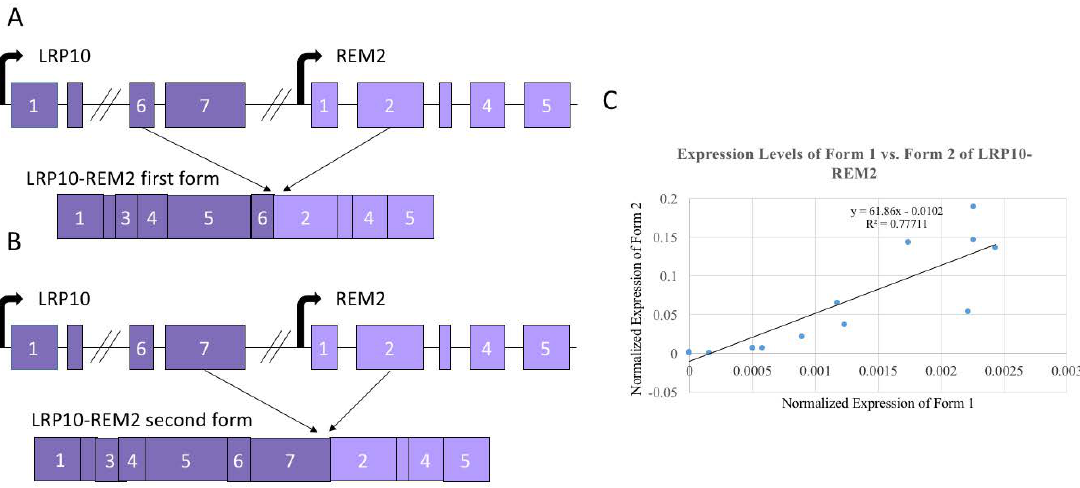
Figure 4. Two isoforms of LRP10-REM2. ( A ) Exon diagram of the first form with 6th LRP10 exon joining to the 2nd REM2 exon (e6e2) of LRP10-REM2 . ( B ) Exon diagram of the second form with 7th LRP10 exon joining to the 2nd REM2 exon (e7e2) of LRP10-REM2 . ( C ) Correlation between the expression levels between the two forms of LRP10-REM2 . Diagrams not to scale with base pair length. 3.5. Alternate Analysis of the Data with Age Buckets also Failed to Show a Prominent